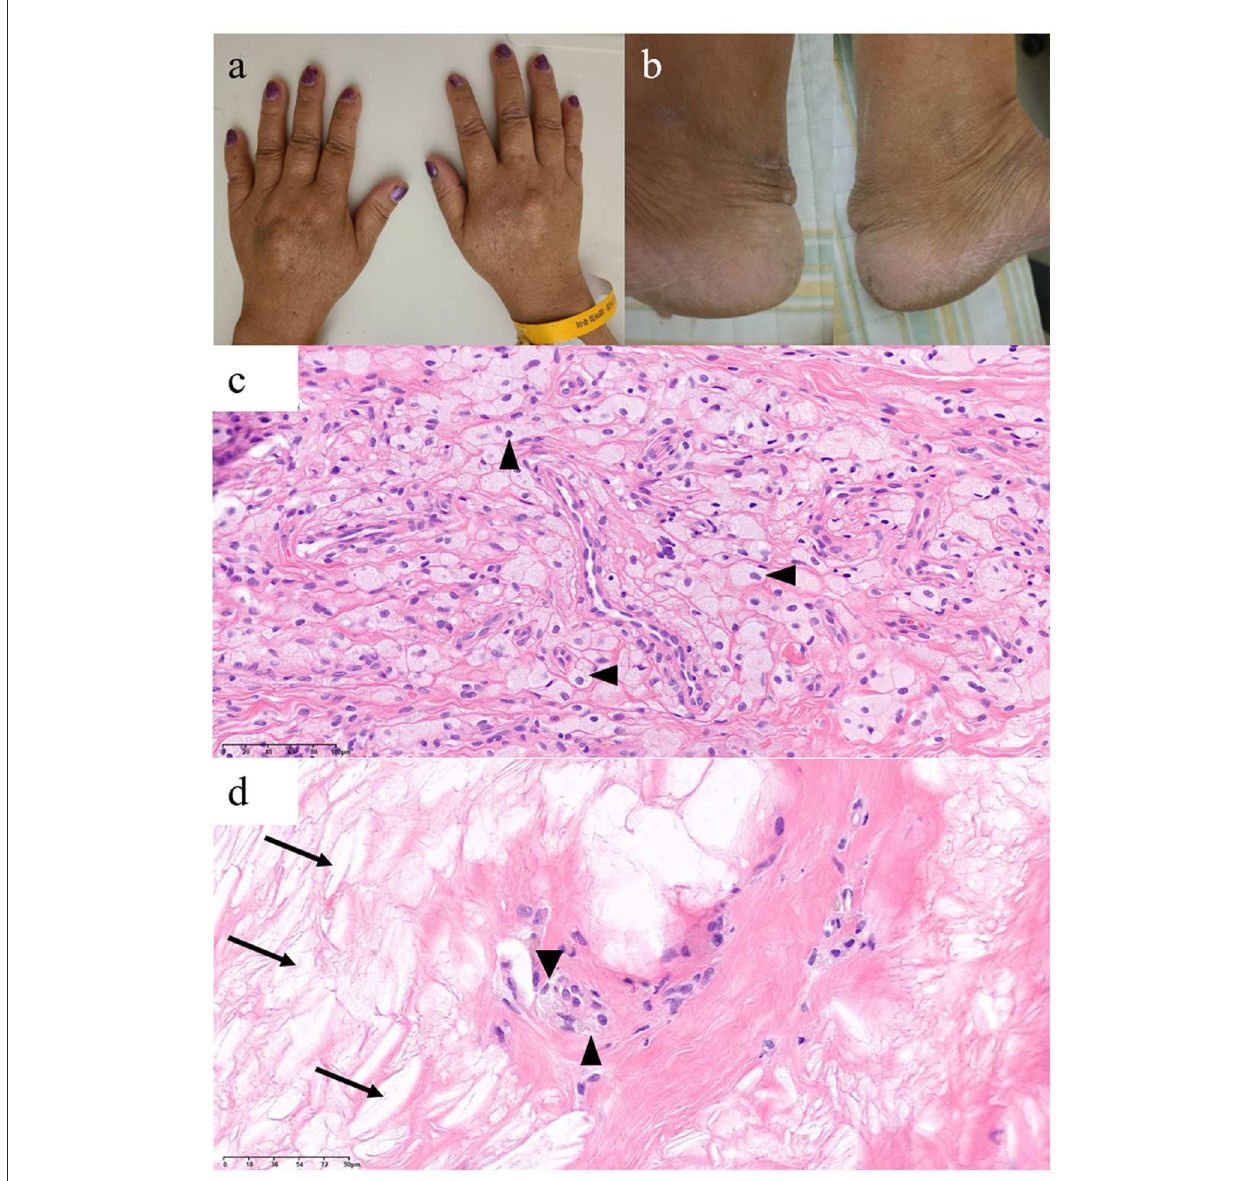
FIGURE1 Xanthomas findings of this patient with cerebrotendinous xanthomatosis. Xanthomas on bilateral (a) dorsum of the hands and (b) Achilles tendons. Histological findings of the dorsum of the hand (c) and Achilles tendon (d) xanthomas show foamy macrophages (arrowheads) and lipid crystal clefts